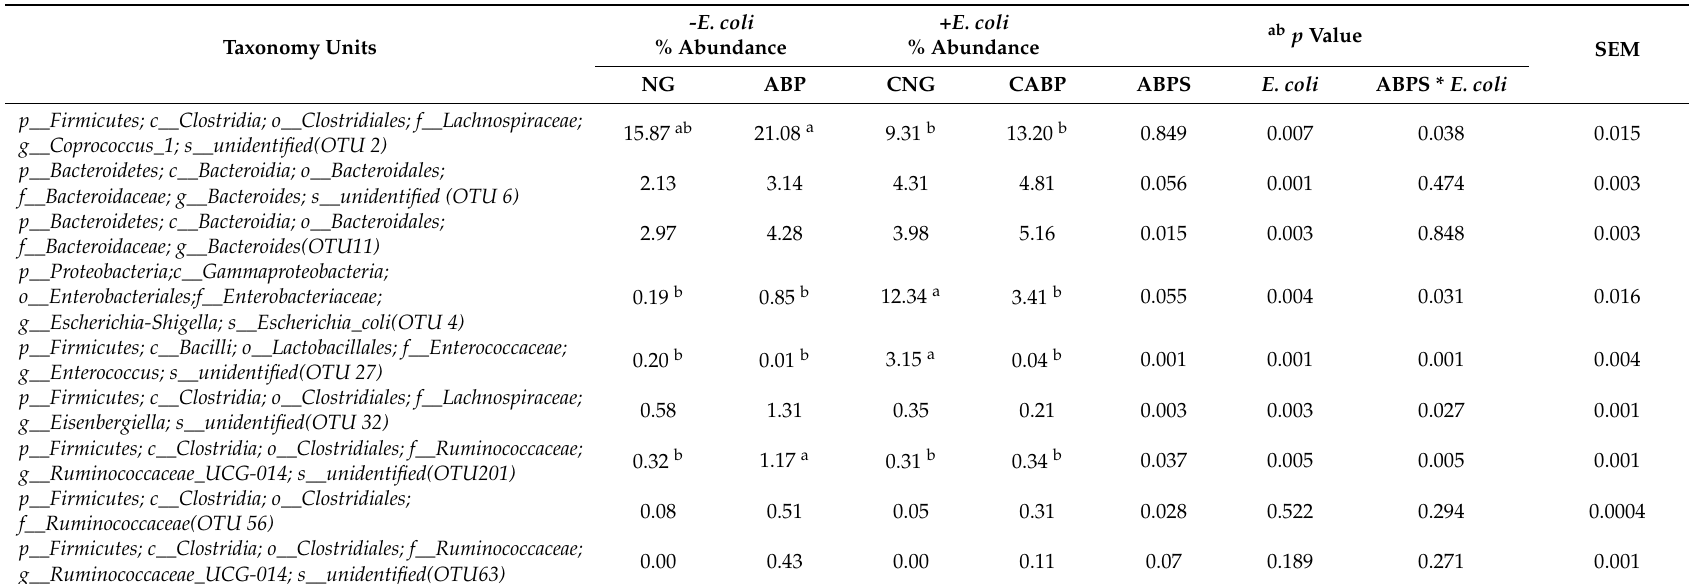
Table 4. Effects of ABPS and E. coli challenge on some different genera in yellow-feathered broilers. Taxonomy